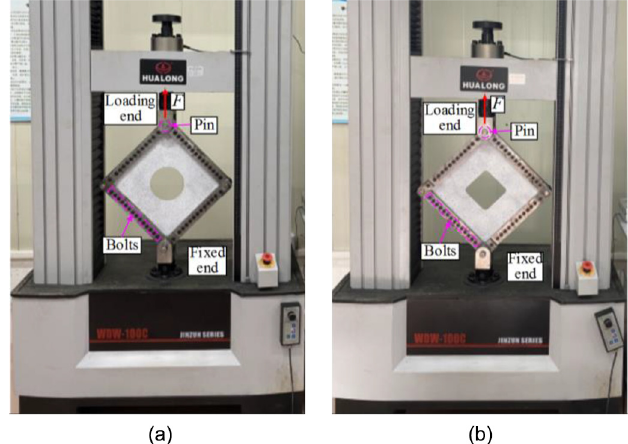
Fig. 5. Shear buckling tests of square plates with different holes. (a) Square plate with circular hole. (b) Square plate with fi llet